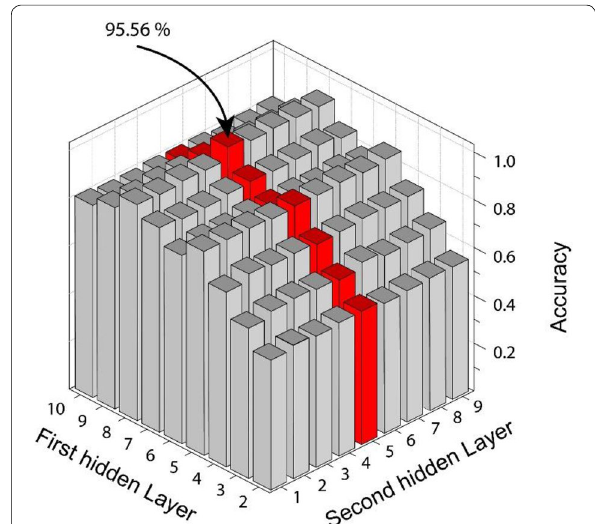
Figure 5 Pocket pressure accuracy according to the number of neurons in hidden layers